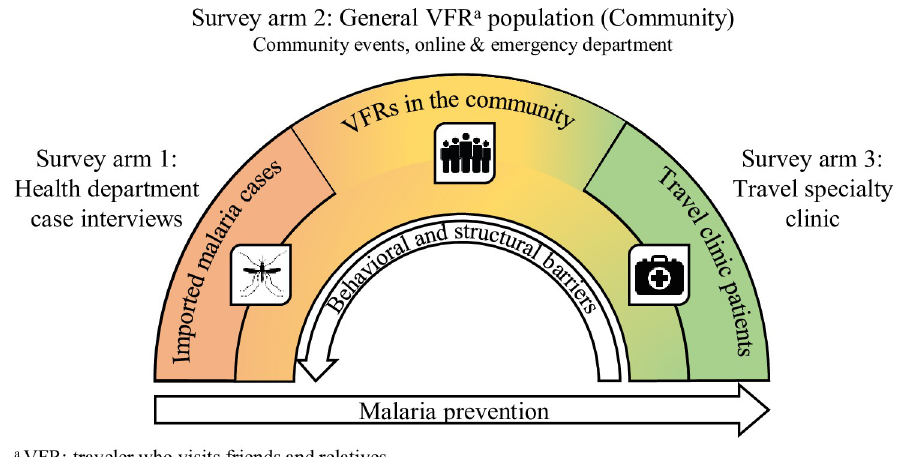
Fig 1. Design of a cross-sectional, multi-setting survey of malaria prevention knowledge, attitudes, and practices among US travelers to sub-Saharan Africa. Participants were surveyed in three study arms. The hypothesized relational directionality of barriers and malaria prevention are shown relative to these three groups, where imported malaria cases were hypothesized to be least effective at preventing malaria and are impacted most strongly by behavioral and structural barriers to malaria